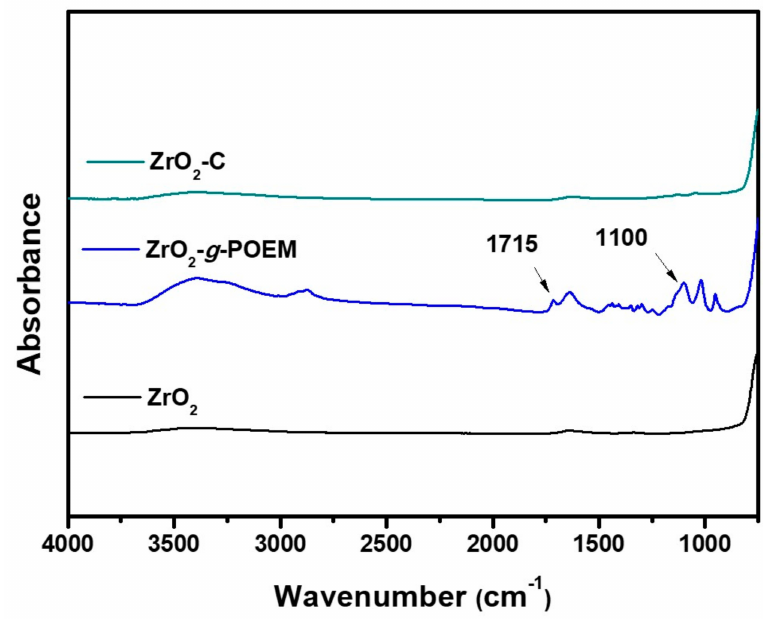
Figure 2. FT-IR spectra of ZrO 2 , ZrO 2 - g -POEM and ZrO 2